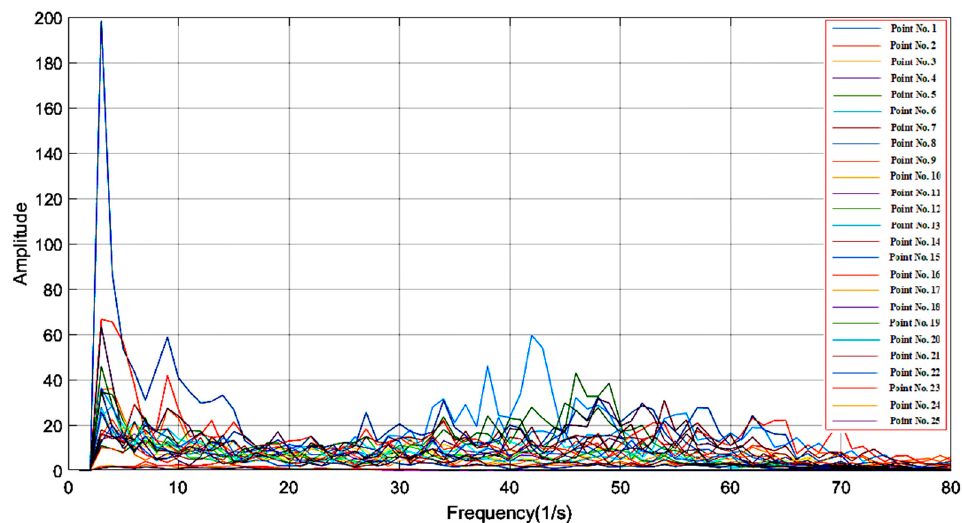
Figure 4. Power spectral density (PSD) analysis of fluctuating pressures for basin II (Fr 1 = 6.14).